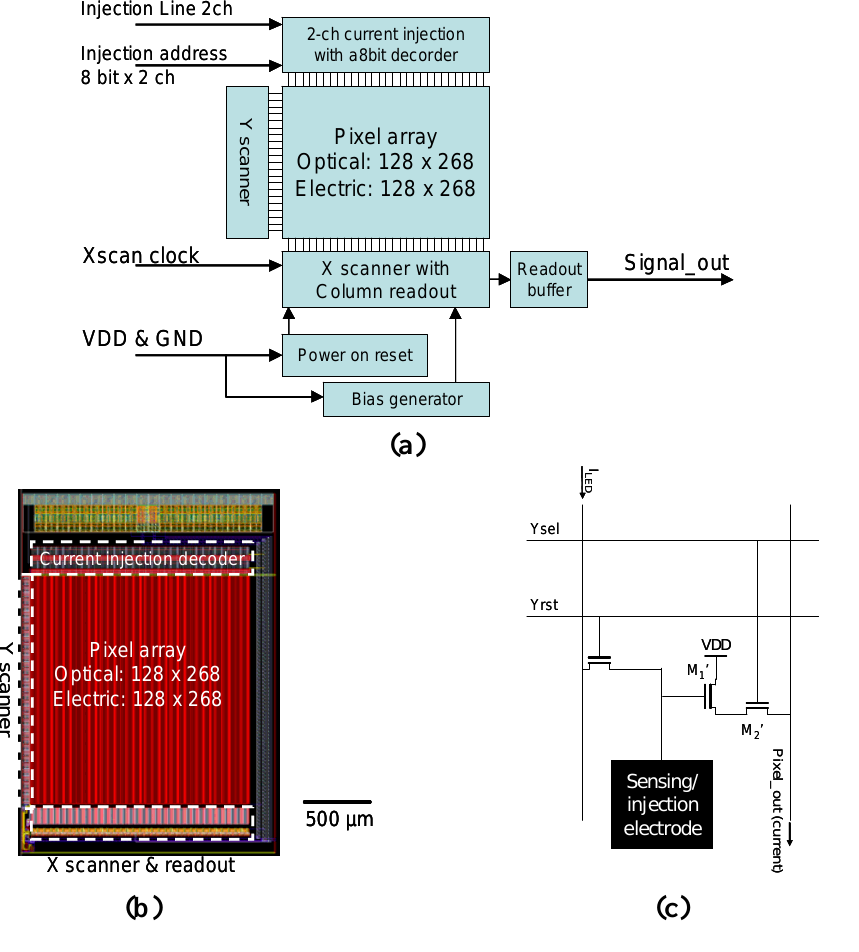
Figure 14. (a) Block diagram, (b) layout, and (c) pixel schematics of the sensor with addressable injection.